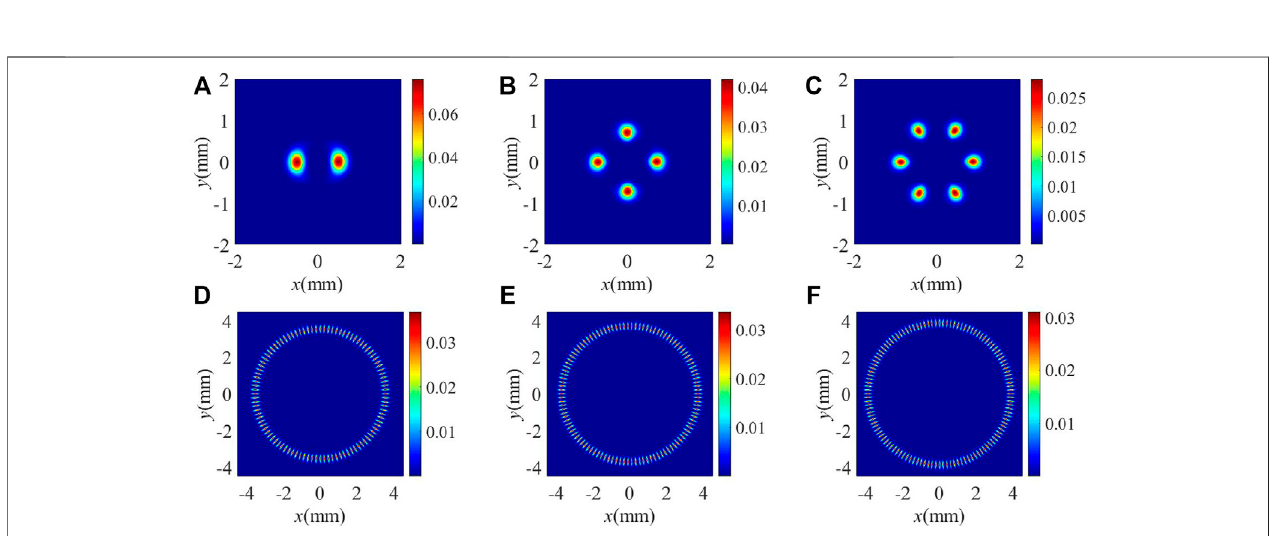
FIGURE6|(A – F) IntensitypatternsoftheFWM fi eldfordifferentTCsofthevortexdriving fi eld. (A) l =2, (B) l =4, (C) l =6, (D) l =100, (E) l =110,and (F) l =120. Ω c = 25 meV and Δ c = 8 meV for (A – C) and Ω c = 13 meV and Δ c = 2 meV for (D – F) . Other parameters are the same as in Figure 2B .